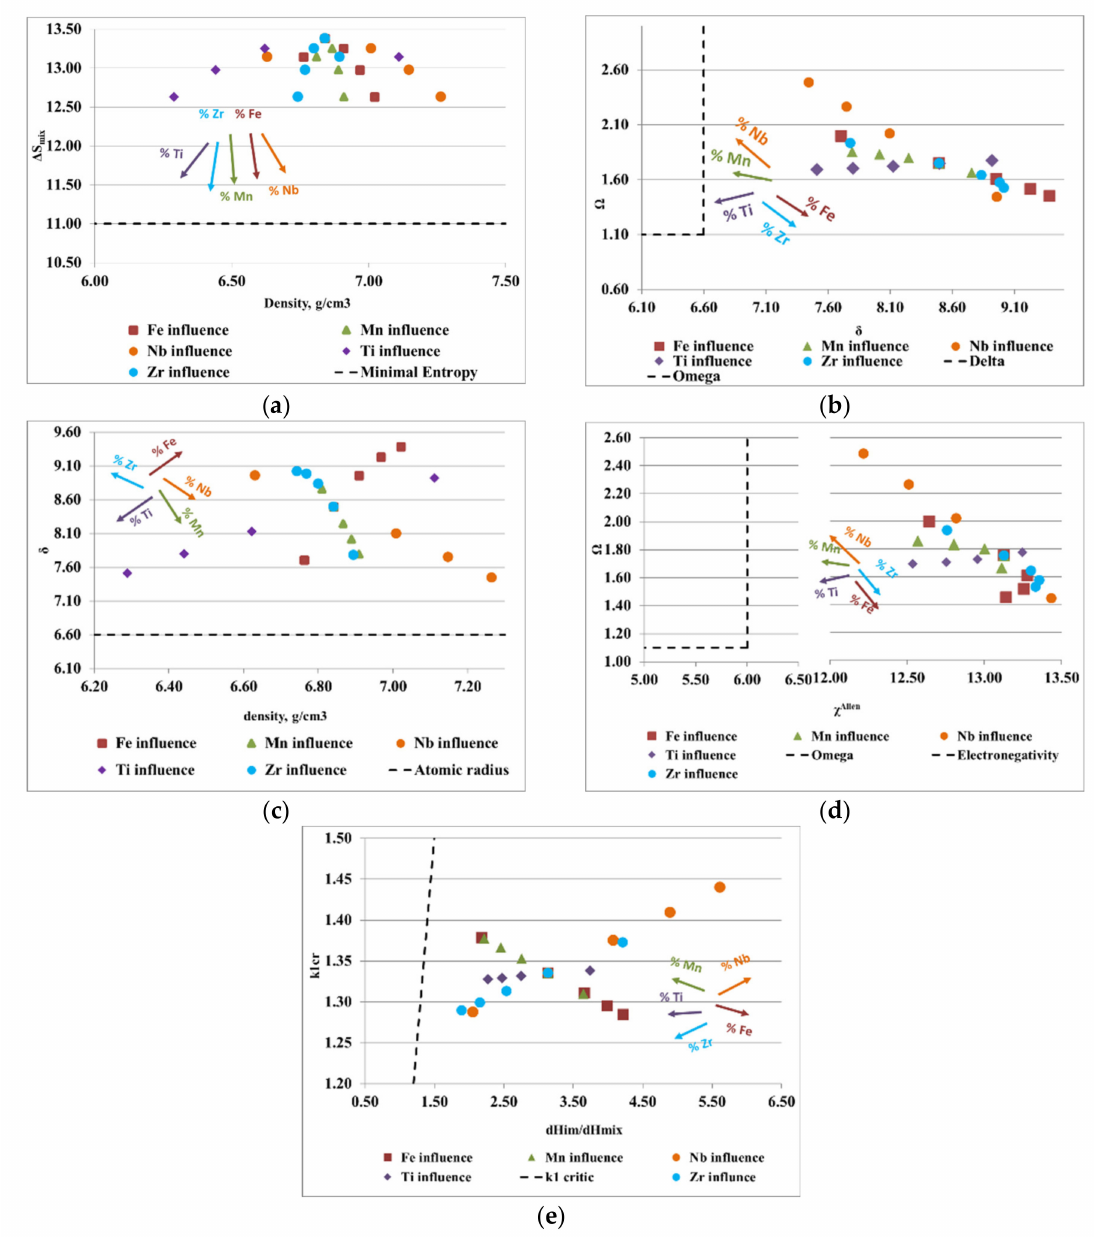
Figure 4. Graphical representation of the variations between ( a ) density, ρ , and the configurational entropy, ∆ Smix; ( b ) the atomic radius difference, δ , and the derived parameter, Ω ; ( c ) density, ρ , and the atomic radius difference, δ ; ( d ) Allen electronegativity, χ Allen , and the derived parameter, Ω ; ( e ) the ratio between the enthalpy of intermetallic compounds ( ∆ Him) and the mixing enthalpy ( ∆ Hmix) with the k1 cr factor for the FeMnNbTiZr alloy